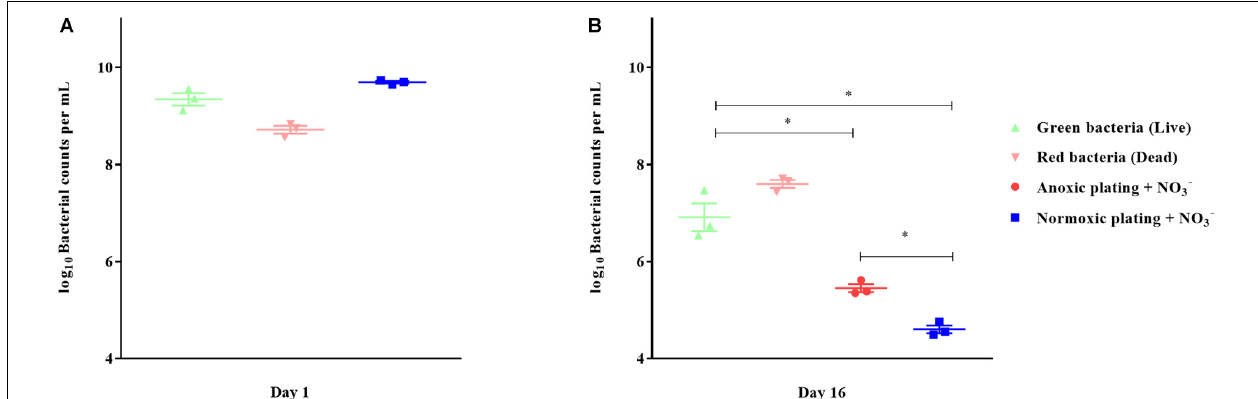
FIGURE 6 | Direct viable counting reveals a viable but non-culturable population of Pseudomonas aeruginosa (PAO1) after anoxic conditioning. Bacterial counts per milliliter were determined with plate counting and direct viable counting from 24-hour-old batch cultures (A) and from 16-day-old anoxic conditioned batch cultures (B) of PAO1. Bacteria were stained with LIVE/DEAD staining to estimate the proportion of viable (live) and non-viable (dead) cells. There was significantly more viable bacterial counts when applying direct viable counting in comparison to normoxic plating ( p < 0.0001, One-way ANOVA test) and anoxic plating ( p = 0.0009, One-way ANOVA). Anoxic plating yielded significantly higher bacterial counts ( p = 0.023, One-way ANOVA test) than normoxic plating. Symbols with error bars indicate the mean ± SEM ( n = 3). + NO 3 - refers to the addition of 10 mM KNO 3 to LB agar plates. ∗ p < 0.05.